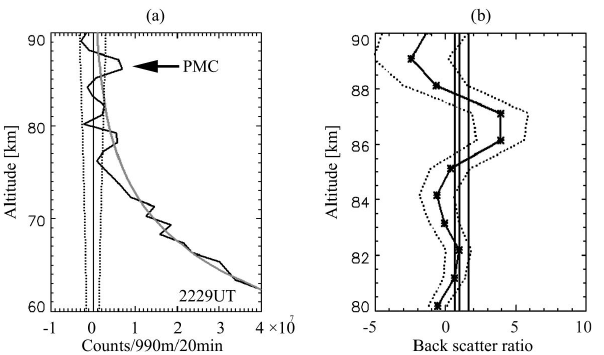
Figure 3. (a) A photon count profile of data integrated between 22:19 and 22:39 UTC. The signal is corrected by multiplying z (altitude) squared to raw count data. The vertical solid and dotted lines indicate zero counts and a 1-sigma error level, respectively. The gray solid curve shows estimated Rayleigh signals. (b) Backscatter ratio (BSR) between 80 and 90 km in altitude. The curved dotted lines show 1-sigma error of BSR. The two vertical lines show variability of an estimated Rayleigh signal relative to 1.0.